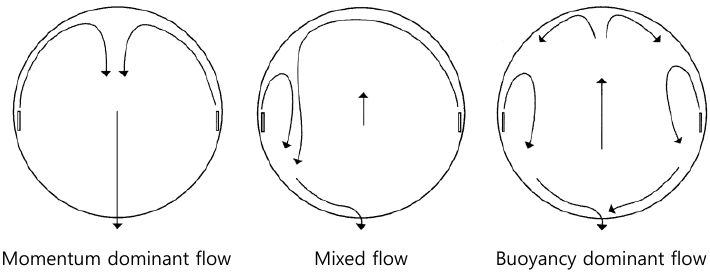
Figure 1. Flow pattern inside a calandria by balance of buoyancy and momentum forces.